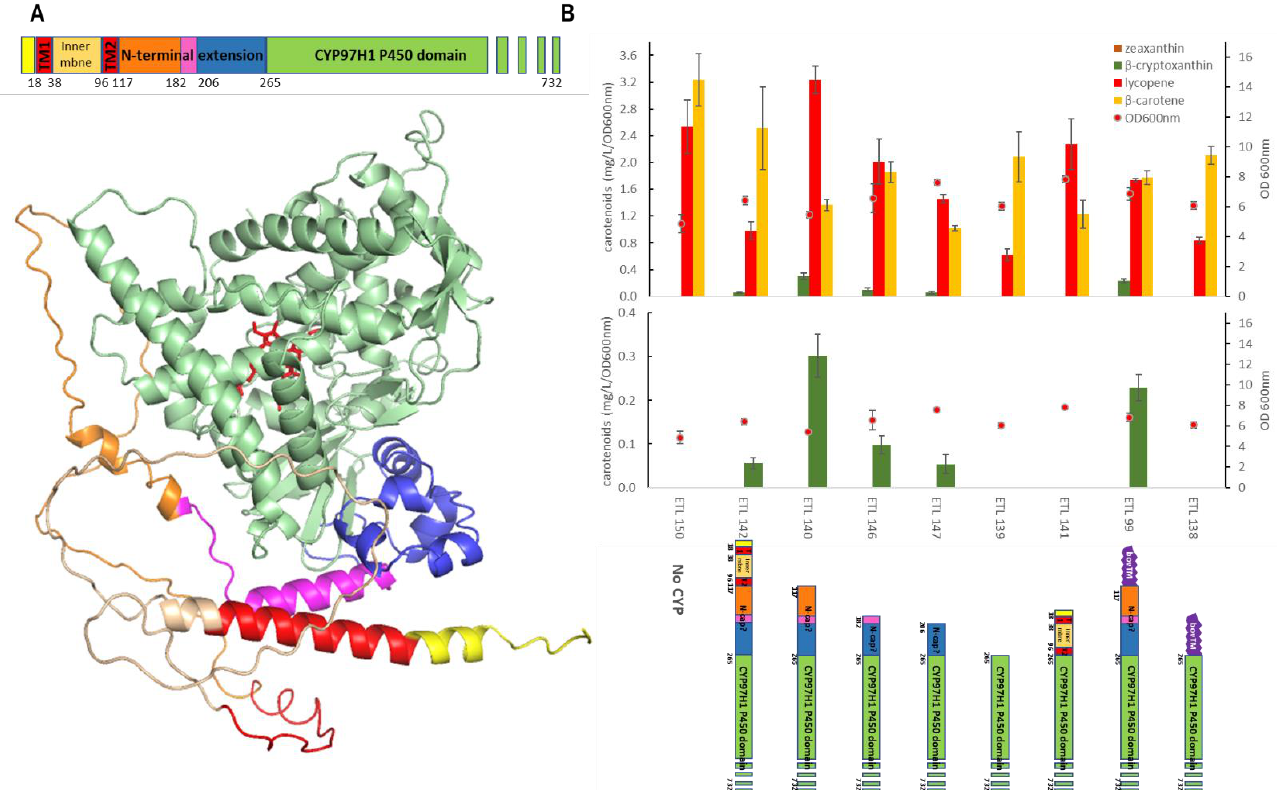
Figure 4. ( A ): Full-length modelling of CYP97H1, with poor modelling of the N-terminal domain. The model was rotated horizontally at 90 °C compared to the CYP97H1 model of Figure 2B. The heme from the CYP97A3 crystal is represented in red. The N-terminal colouring represents the sequential truncated mutants assayed. ( B ): In vivo carotenoid production in strains expressing CYP97H1 N-terminal